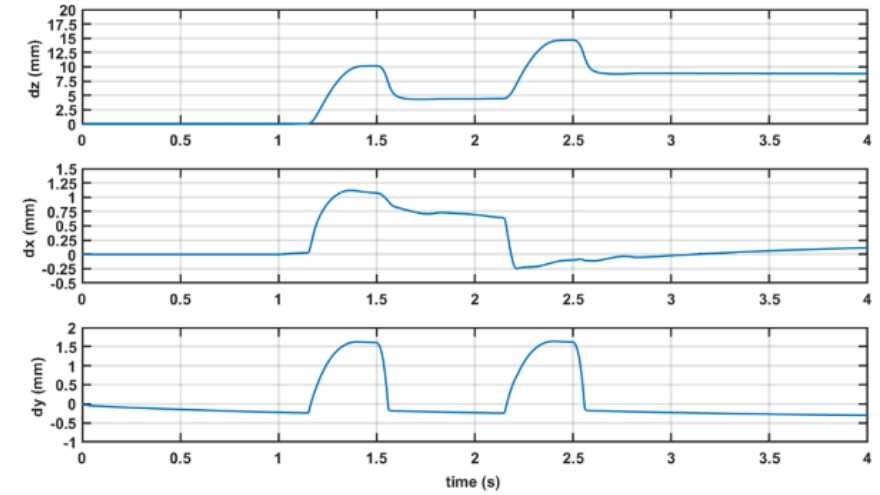
Figure 14. The components of displacement of the center of mass (CoM) in the x , y , and z directions in one sprawling cycle.